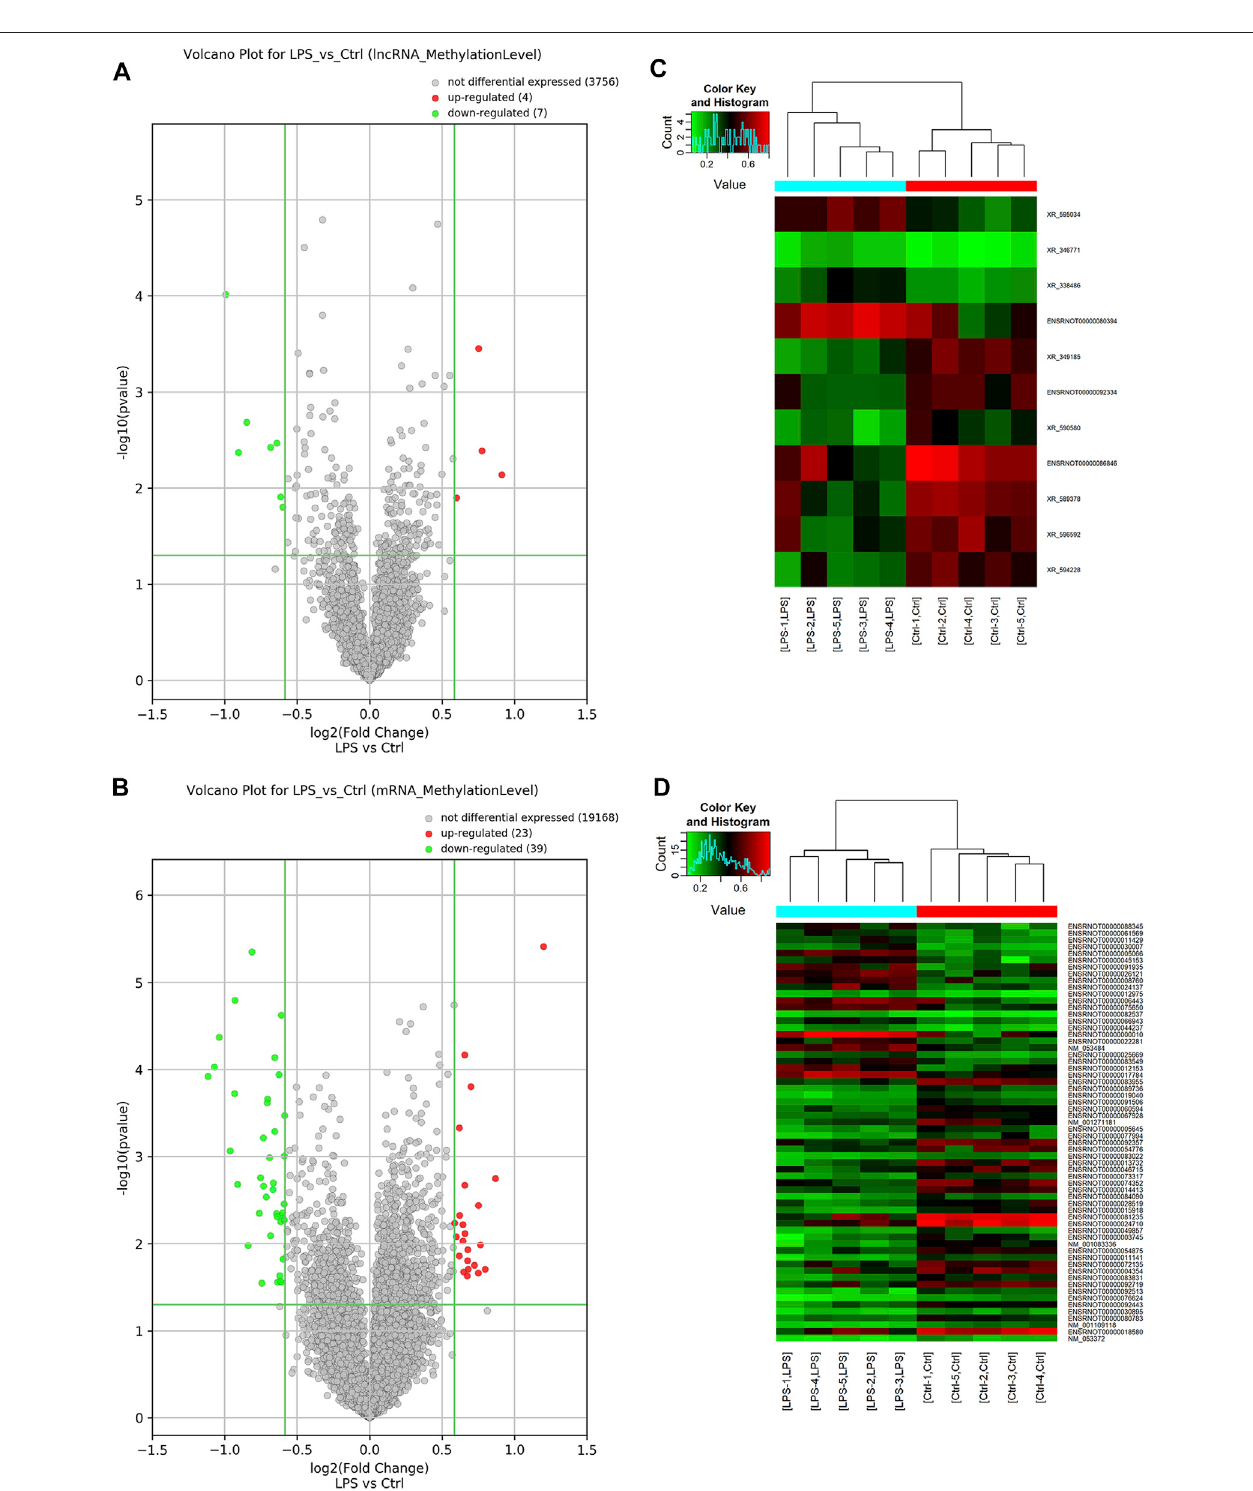
FIGURE 2 | M 6 A modi fi cation pro fi les of lncRNA& mRNA in LPS and control group. (A) Volcano plots showing the lncRNAs that were differentially methylated between LPS and control group with statistical signi fi cance. (B) Volcano plots showing the mRNAs that were differentially methylated between LPS and control group withstatisticalsigni fi cance(foldchanges ≥ 1.5and p < 0.05). (C) Hierarchicalclusteringanalysisthedifferentially methylatedlncRNAs. (D) Hierarchical clusteringanalysis the differentially methylated mRNAs. Ctrl, control; LPS, lipopolysaccharide.